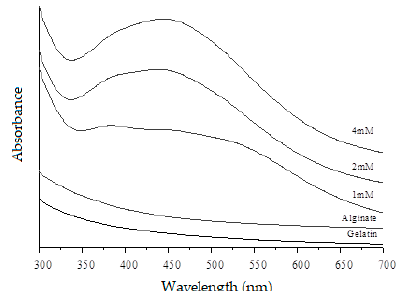
Figure 1. Ultraviolet-visible (UV–Vis) absorption spectra of sodium alginate, gelatin, and hydrogel with silver nanoparticles at different concentrations (1 mM, 2 mM, and 4 mM).